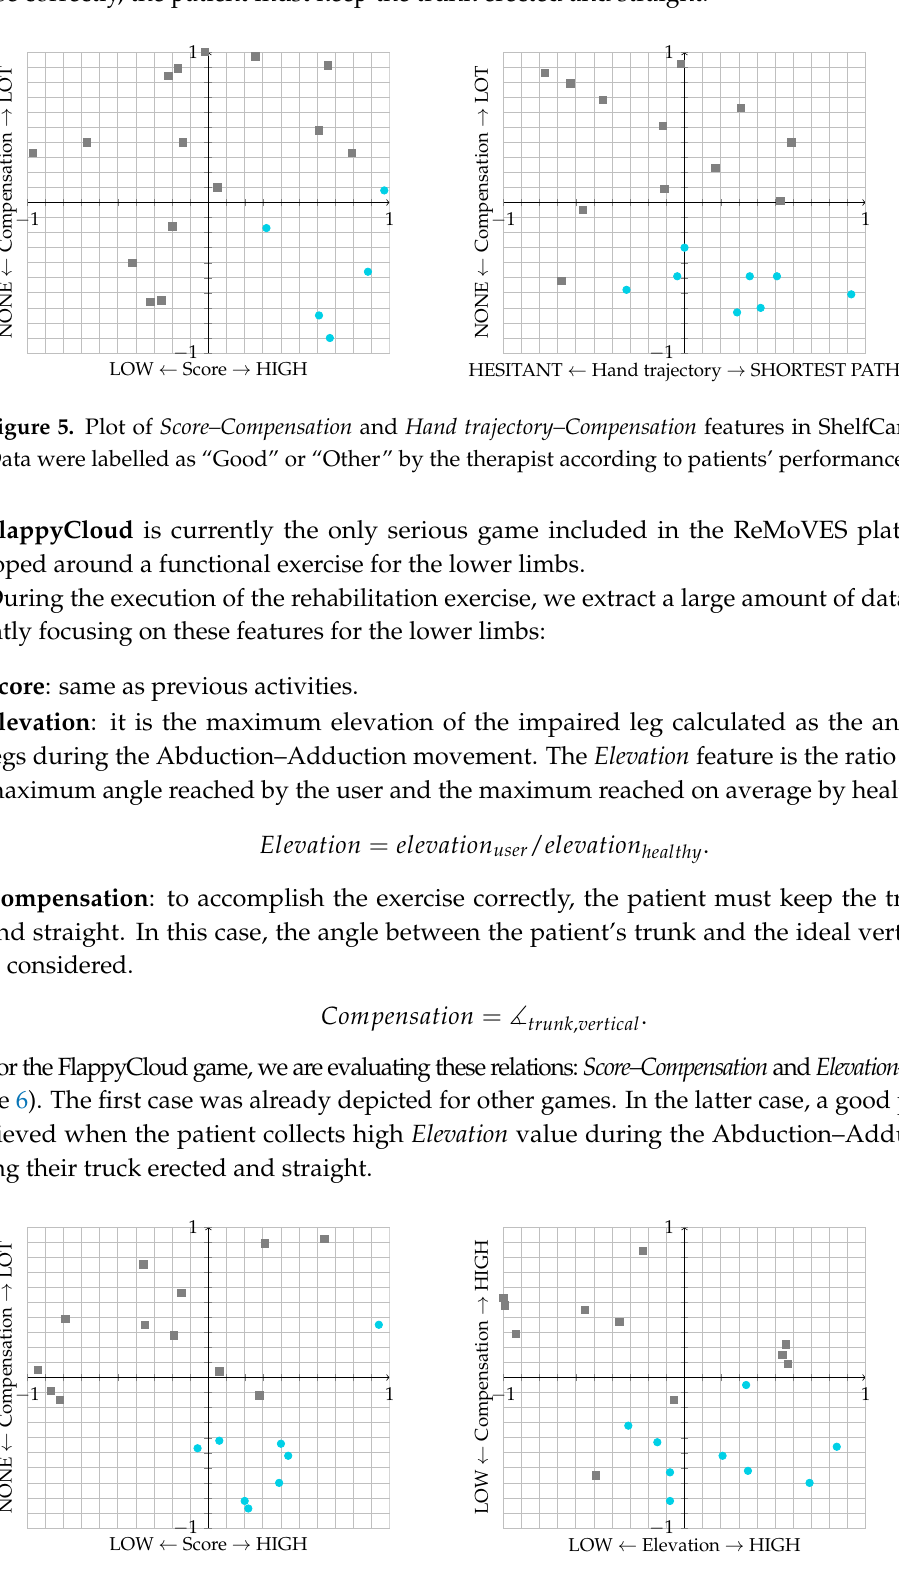
Figure 6. Plot of Score–Compensation and Elevation–Compensation features in the FlappyCloud game. Data were labelled as “Good” or “Other” by the therapist according to patients’